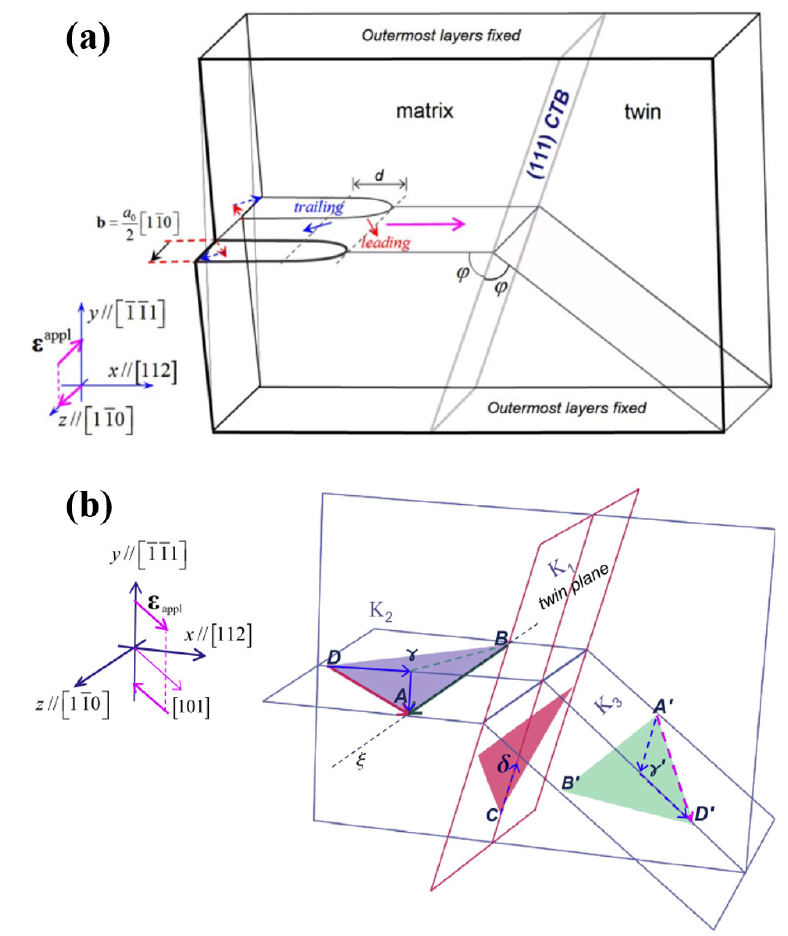
Figure 1. Configuration of a twinned bi-crystal for simulating the interaction between ( a ) an incident screw dislocation and ( b ) a perfect lattice dislocation with a coherent twin boundary in fcc metals. ε appl denotes the applied shear strain that drives the dislocation towards the twin boundary. Figures taken from Refs. [19,20] with